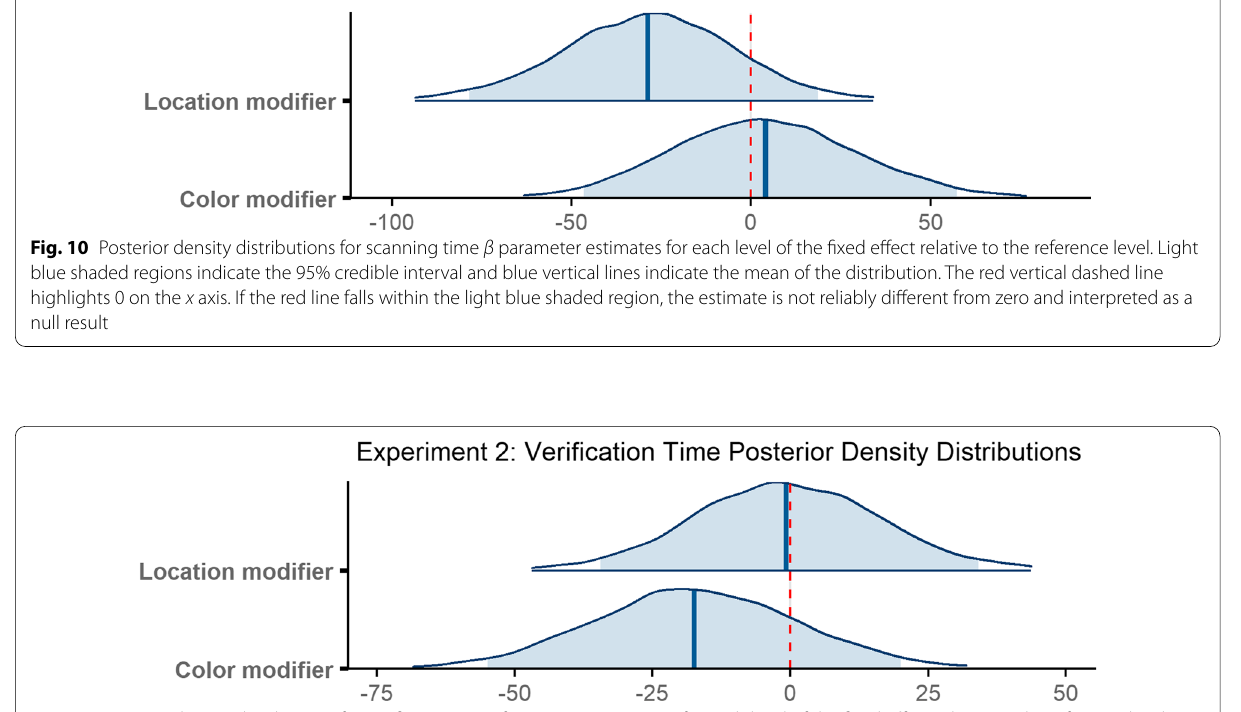
Fig. 11 Posterior density distributions for verification time β parameter estimates for each level of the fixed effect relative to the reference level. Light blue shaded regions indicate the 95% credible interval and blue vertical lines indicate the mean of the distribution. The red vertical dashed line highlights 0 on the x axis. If the red line falls within the light blue shaded region, the estimate is not reliably different from zero and interpreted as a null